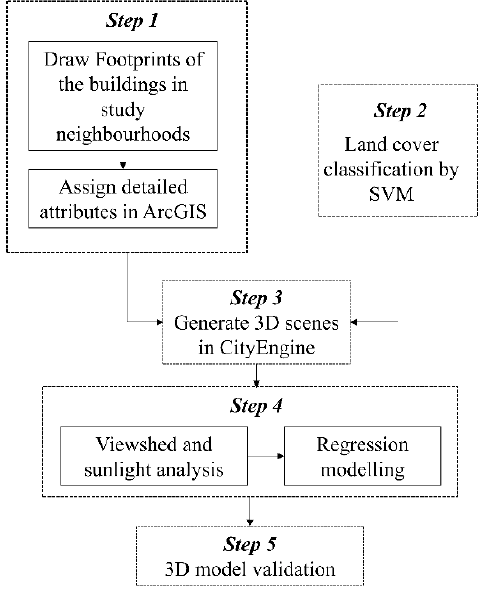
Figure 3. Workflow for 3D modelling.